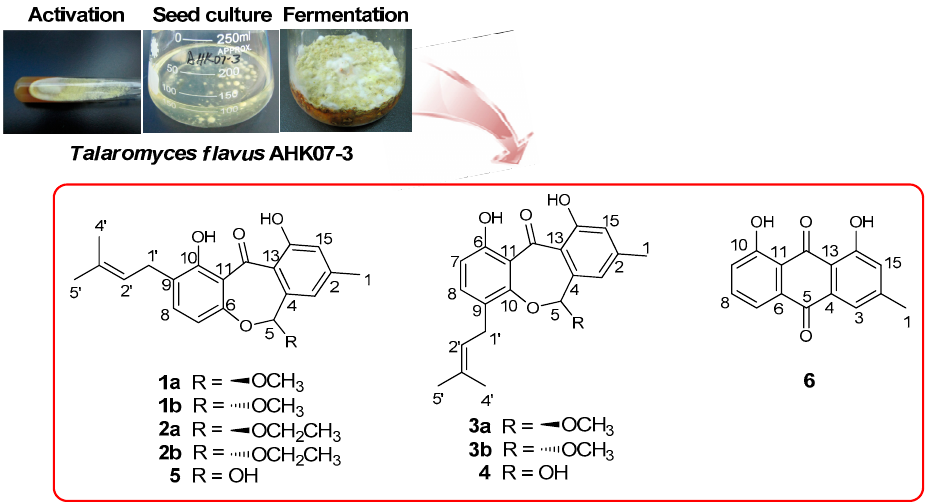
Figure 1. Production and chemical structures of 1 – 6 .